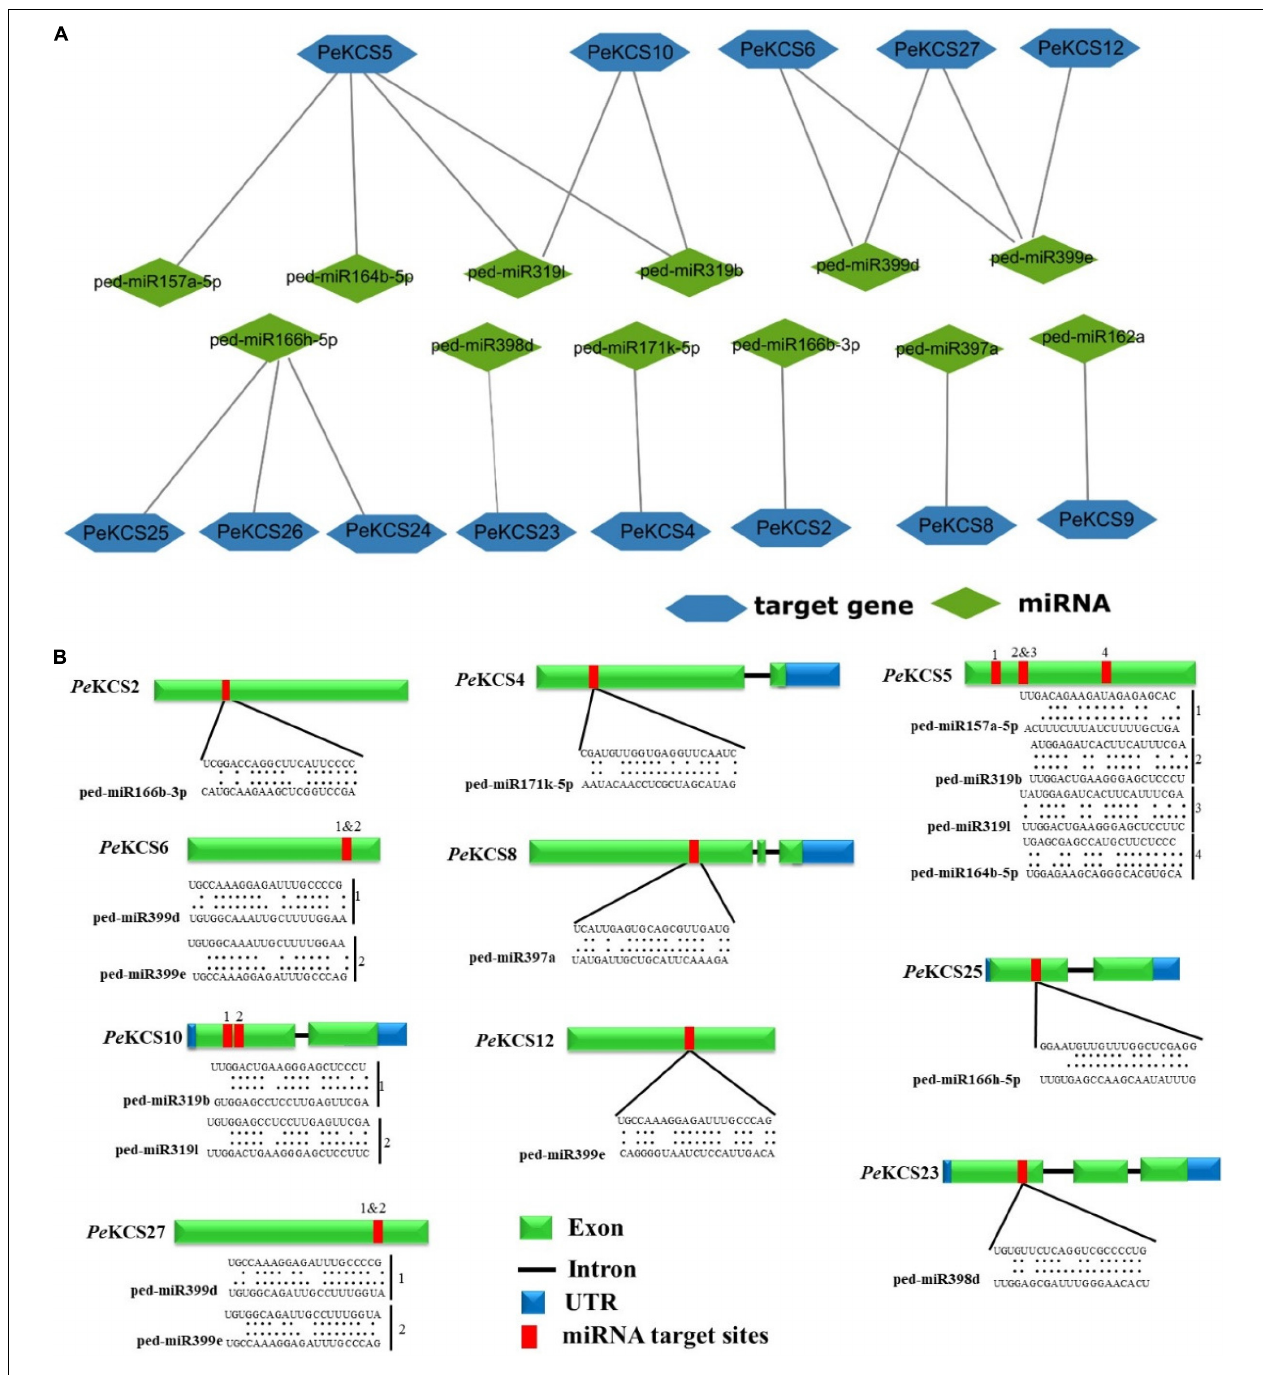
FIGURE 7 | Predicted miRNAs targeting PeKCS genes. (A) Network illustration of predicted miRNA targeted PeKCS genes. Green ellipse shapes represent the predicted miRNAs and bluish hexagon shapes represent targeted PeKCS genes. (B) The schematic diagram indicates the PeKCS targeted by miRNAs and the putative miRNAs sites are indicated by red color, upper sequences are from the gene region and lower sequences are from the miRNAs ( Supplementary Table 8 for detailed information of all the predicted miRNAs and targeted PeKCS genes). association with the P. edulis KCS gene family suggesting that, in addition to segmental duplications, the whole-genome duplications also play an important role in the evolution of the The protein–protein interaction network analysis of PeKCS PeKCS gene family. proteins based on known Arabidopsis proteins was